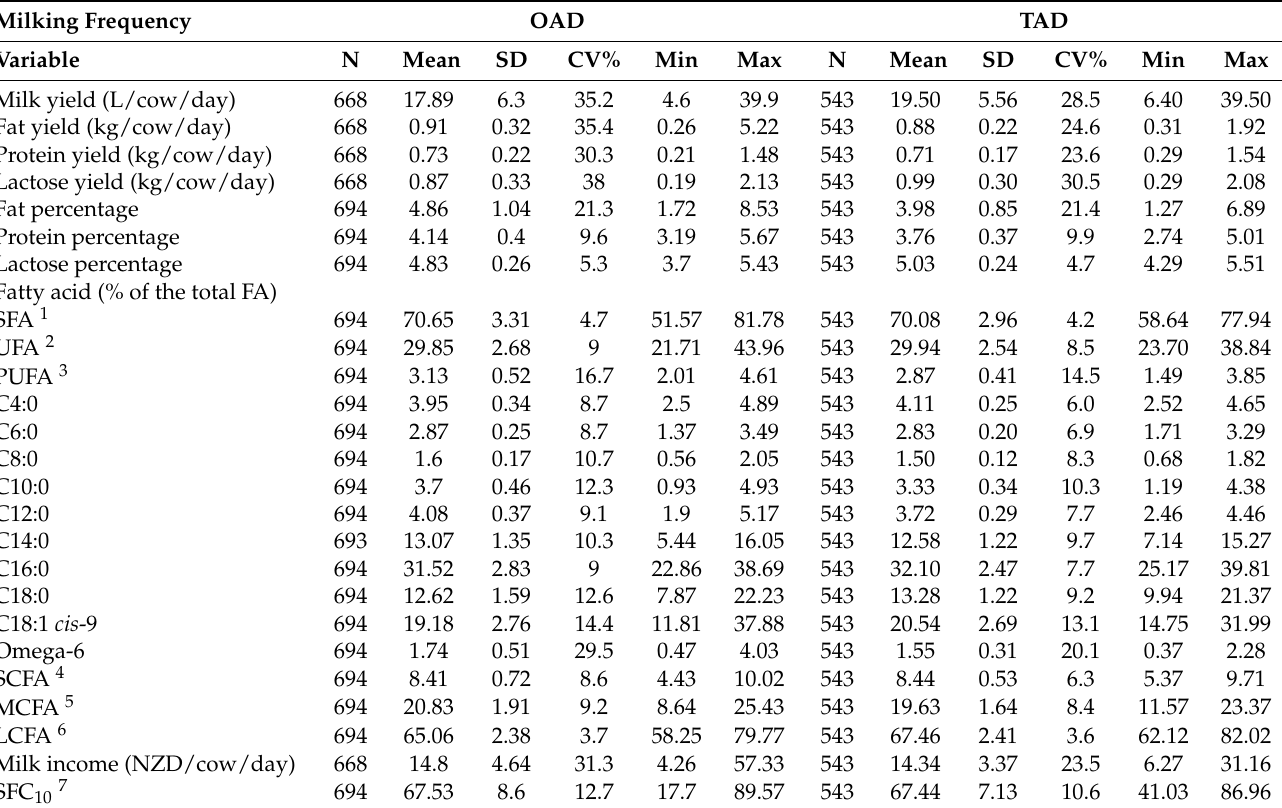
Table 2. Descriptive statistics of production traits, gross milk composition, and fatty acid